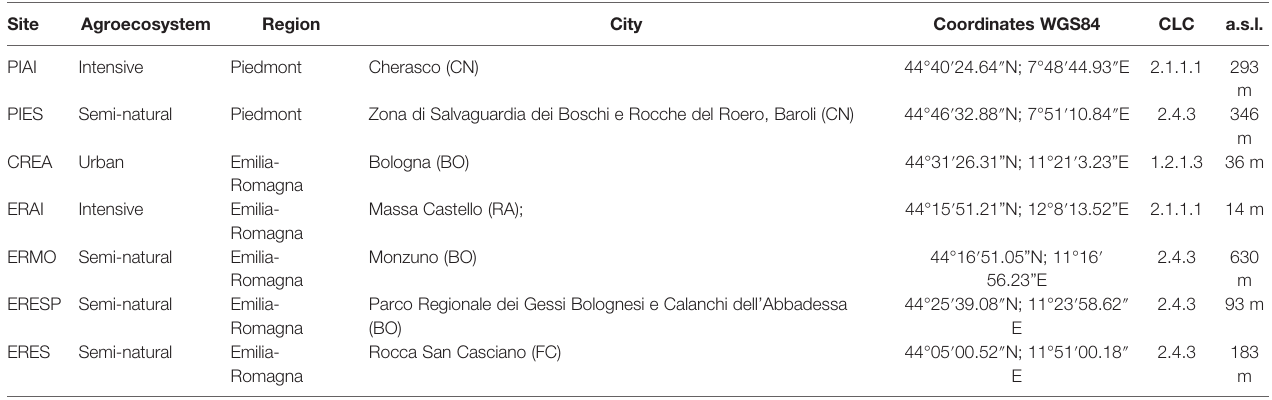
TABLE 1 | Geographical and environmental characterisation of the sites included in the study.